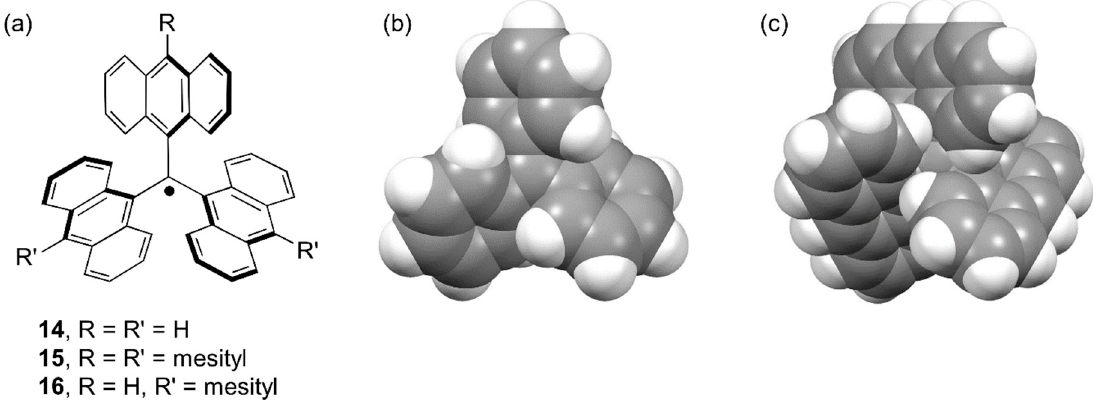
Figure 14. ( a ) Trianthrylmethyl radicals ( 14 , 15 , and 16 ). Space-filling models of ( b ) 1 and ( c ) 14 .